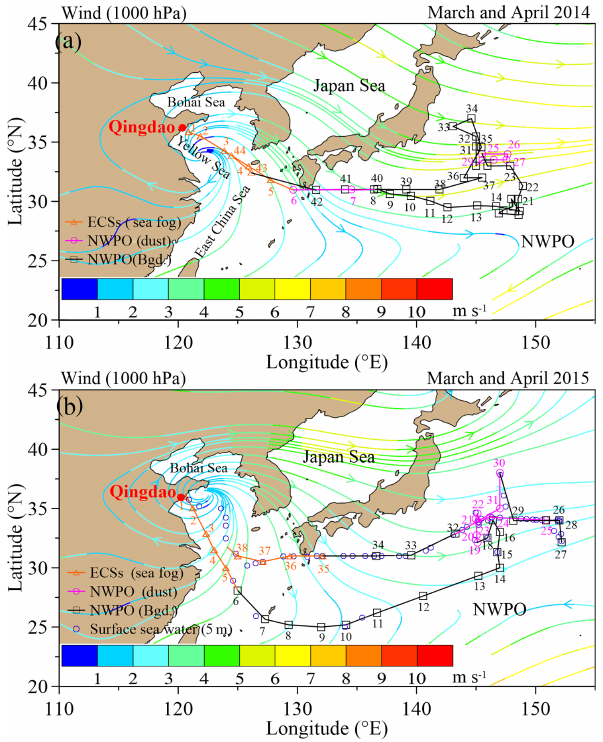
Figure 1. Regional wind streamlines (in ms − 1 ) at 1000hPa dur- ing the Asian winter monsoon period ( a , March and April in 2014 and b , March and April in 2015) based on an NCEP dataset. Cruise tracks are also shown (orange, pink and black indicate sea fog, dust and background aerosol, respectively). The aerosol number and col- lection range are shown in orange, pink and black for sea-fog mod- ified, dust and background aerosol, respectively. The blue open cir- cles in (b) indicate the locations of surface seawater sample (at a depth of 5m) during the 2015 cruise. Hereafter, the Bgd. is the ab- breviation of background aerosol in all the figures and